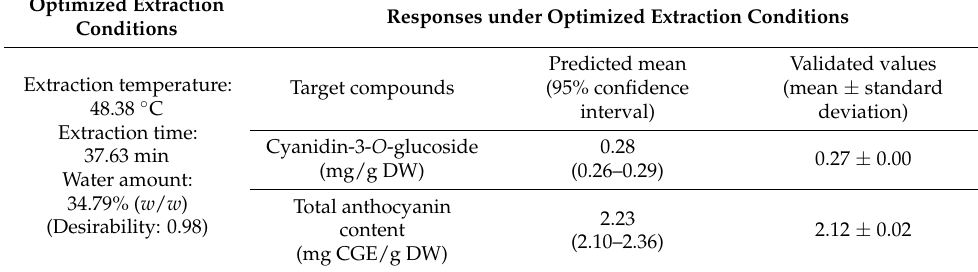
Table 4. Comparison of predicted and experimentally obtained extraction yields of monitored responses under determined optimal extraction